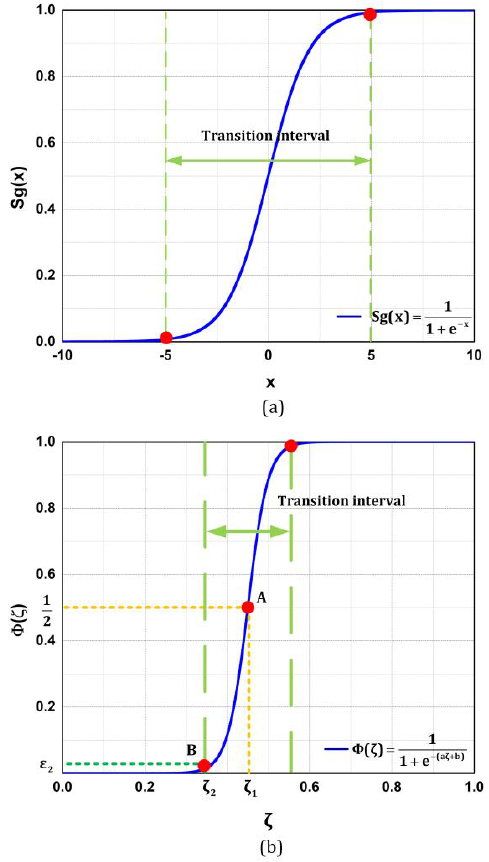
Figure 3. Schematic diagram of the mapping function: ( a ) the standard sigmoid function; ( b ) the modified sigmoid function.